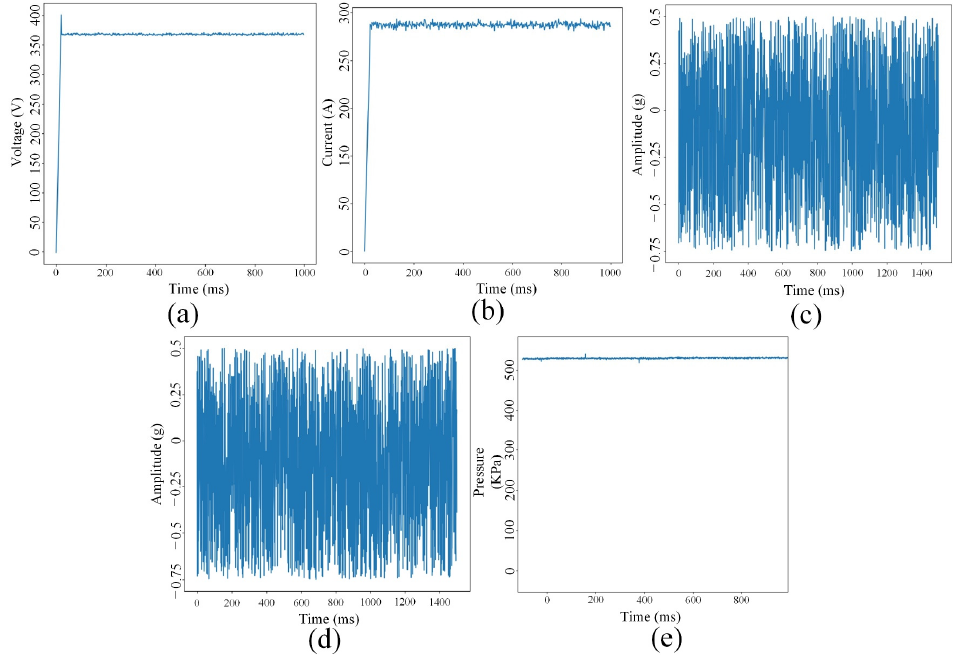
Figure 4. Data of A-class thermal insulation board production line collected in real time. The graphs ( a – e ) are voltage, current, vibration-x, vibration-y and pressure, respectively.